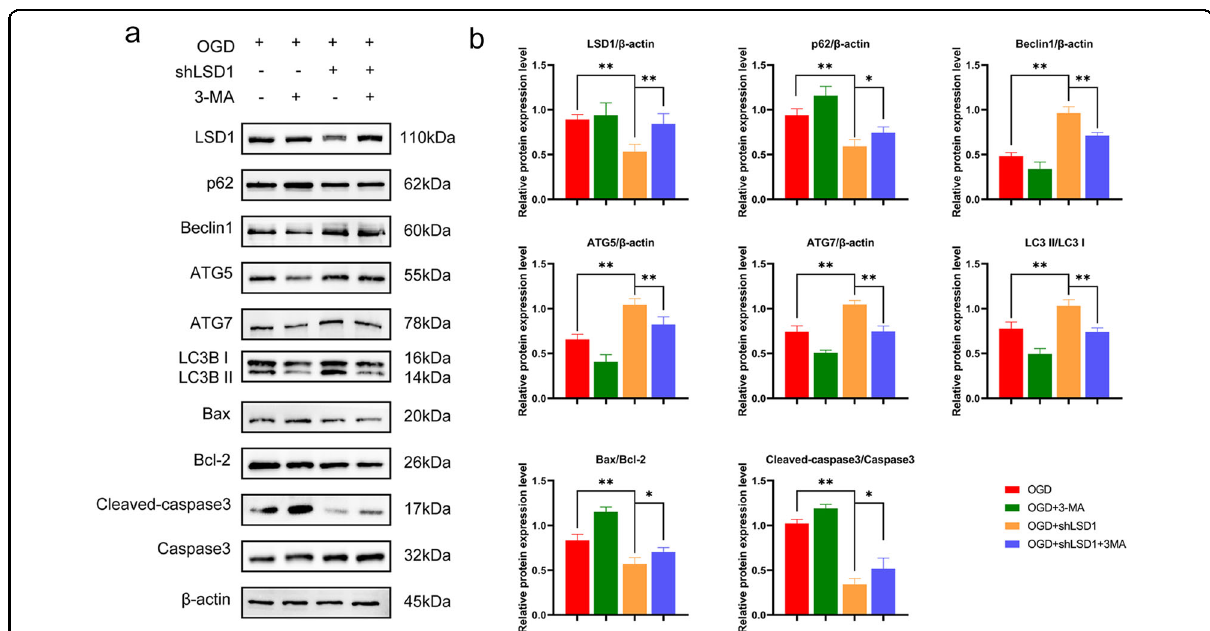
Fig. 6 3-MA partially eliminates the effect of autophagy enhancement and apoptosis suppression in vitro. a LSD1 Western blot analysis, autophagy and apoptosis proteins following injury in different groups. b Semi-quantitative detection of autophagy and apoptosis protein levels. One-way ANOVA and Tukey ’ s multiple comparisons test was used to compute p values for mean ± SD of three independent experiments. * p < 0.05; ** p <